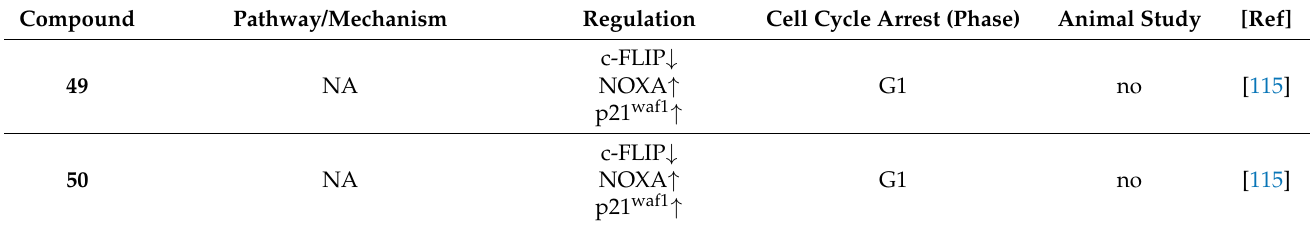
Table 6. Summarized information on UA analogs (modifications at multiple positions).